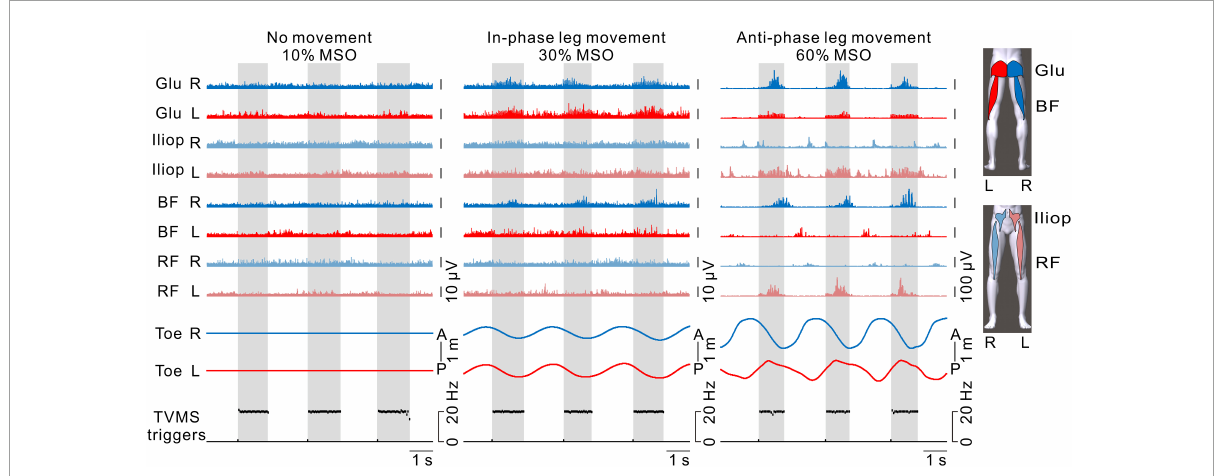
FIGURE6 The activation patterns of hip flexor and extensor muscles in both legs. From left to right, examples with transvertebral magnetic stimulation (TVMS) at 10%, 30%, and 60% maximum stimulator output (MSO). The blue and red traces represent electromyography (EMG) responses in the right and left leg muscles, respectively. The traces with light and dark colors represent EMG responses in the anterior (iliopsoas [Iliop], rectus femoris [RF]) and posterior (gluteus maximus [Glu], biceps femoris [BF]) muscles, respectively. Note that stimulus artifacts were removed from the EMG traces by flattening for 5 ms from the stimulus triggers. Right and left toe movements and the TVMS triggers are shown as in Figure 2B . Gray hatched areas indicate the periods of TVMS